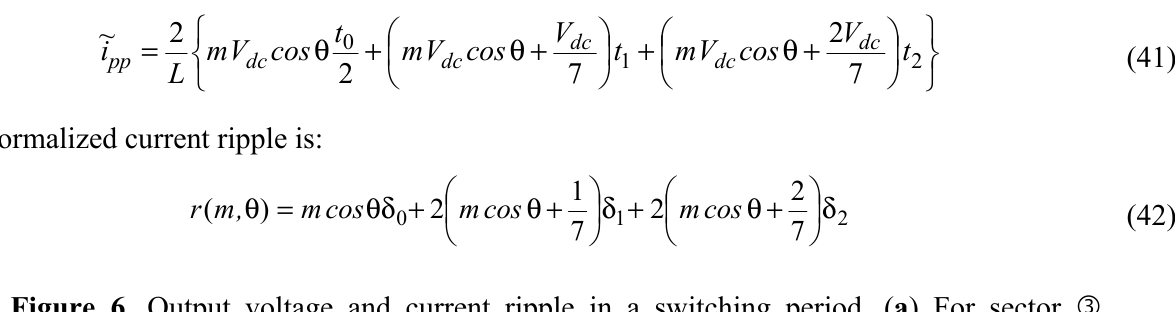
Figure 6. Output voltage and current ripple in a switching period. ( a ) For sector  , 2 π /7 ≤ θ ≤ 3 π /7; and ( b ) for sector  , 3 π /7 ≤ θ ≤ π